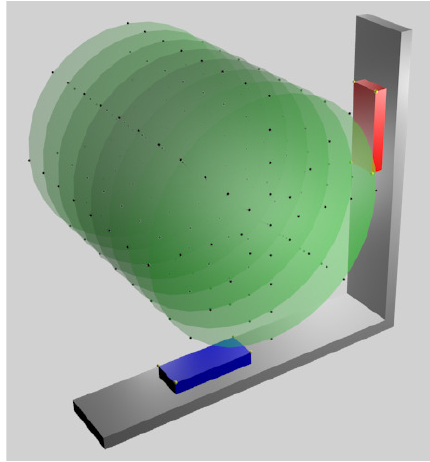
Figure 2. Representation of the measurements points inside a cylindrical green ROI, cut into circles spaced 3 cm from each other and of the points (represented in yellow) collected on the corners of the superior surface of each